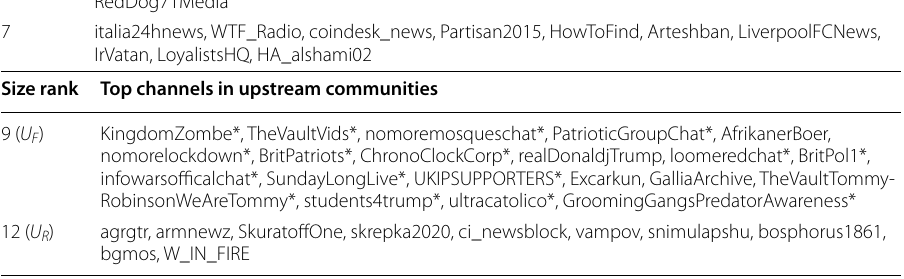
We give the top channels ranked by their in‑Katz centrality for channels in the downstream and core clusters and ranked by their out‑Katz centrality in the upstream clusters. We show the top 20 channels, sorted according to their Katz score, in communities linked to the UK and US far‑right and the top 10 channels in other communities. Channels marked with an asterisk correspond to group chats while the other ones correspond to broadcast channels